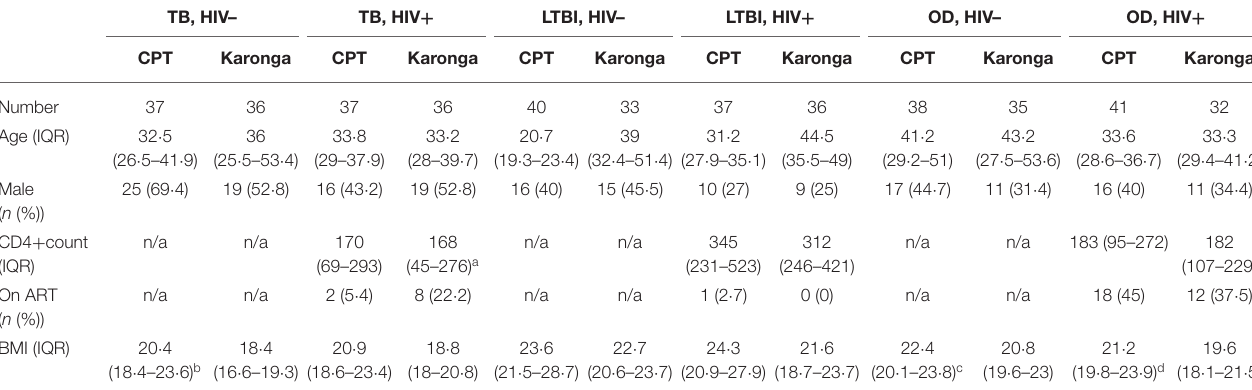
TABLE 1 | Demographic and clinical features for the 438 participants randomly selected from the ILULU-TB cohort for this study. TB, HIV– TB, HIV + LTBI, HIV– LTBI, HIV +